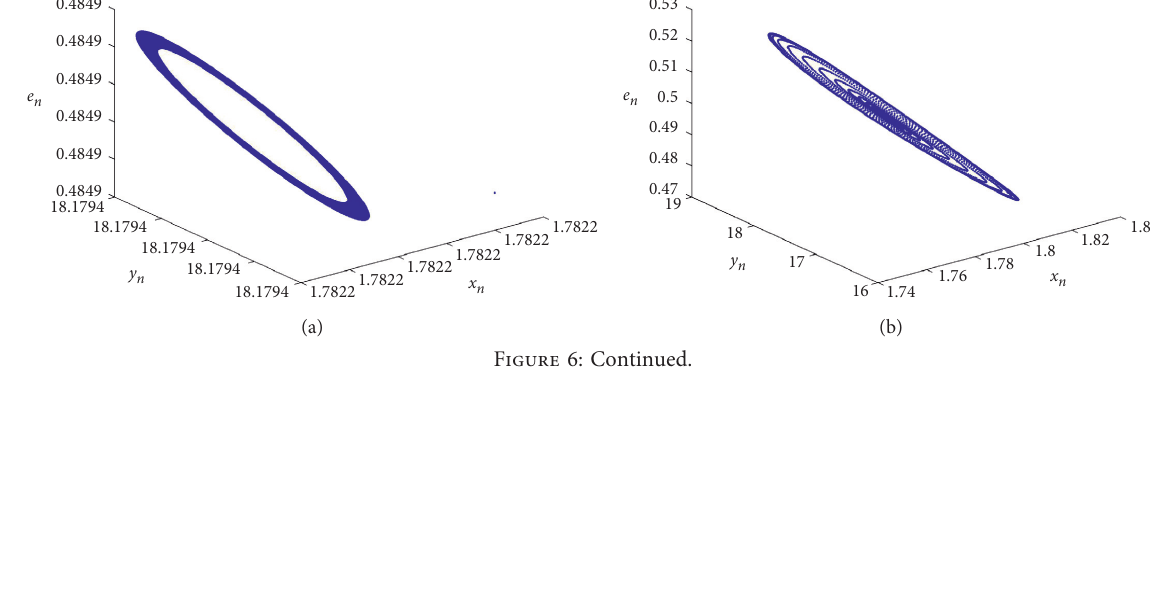
n . (b) Bifurcation diagram for y n . (c) Bifurcation diagram for